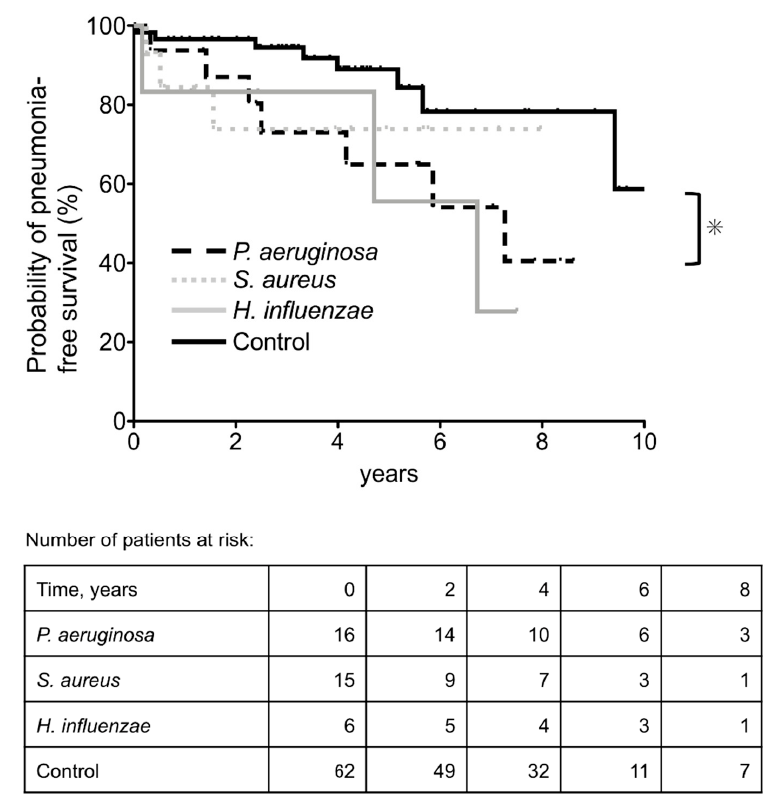
Figure 2. Log-rank tests revealed that the Pa group had a significantly higher incidence of pneumonia ( p = 0.026).